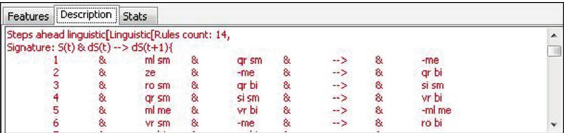
Figure 10: The methodology of testing.